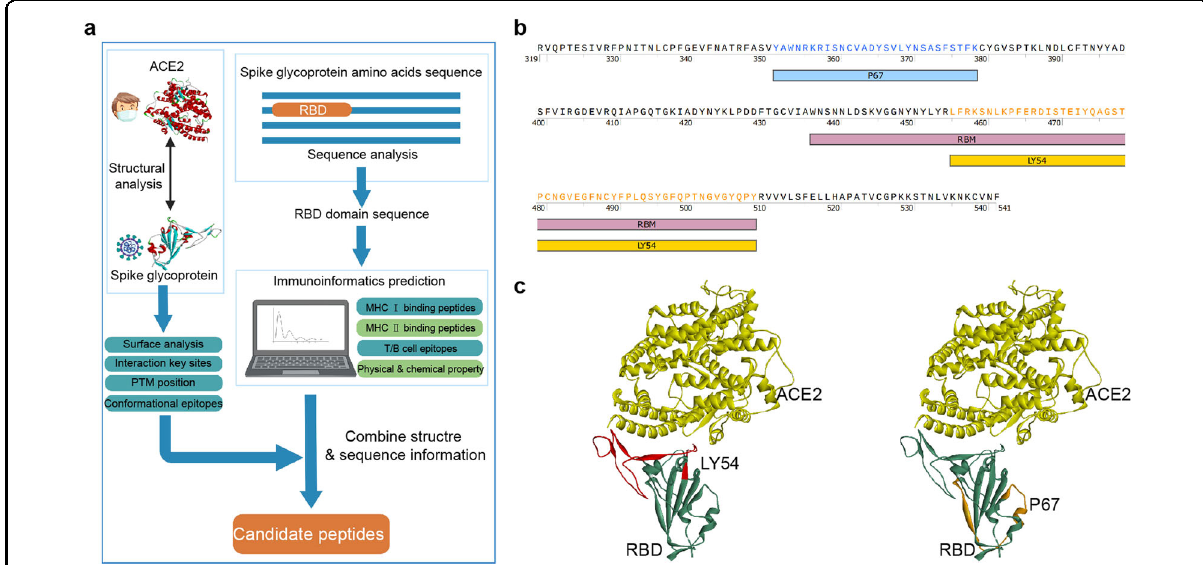
Fig. 1 Identi fi cation of immunodominant candidate peptides. a The fl owchart illustrates the prediction and screening process of the RBD immunodominant peptides. b The amino acid sequences of candidate peptides LY54 and P67. RBM receptor-binding motif. c The spatial localization of candidate peptides LY54 and P67 in the RBD. The crystal structure of the SARS-CoV-2 RBD bound to ACE2 was obtained from the Protein Data Bank (PDB; code 6M0J). The red color shows the location of LY54 and the orange color shows the location of